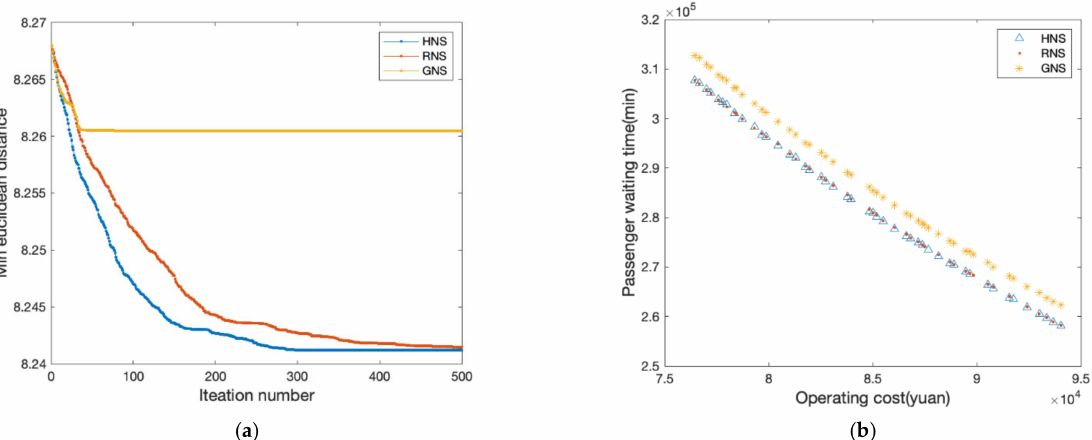
Figure 18. The comparison of different algorithms. ( a ) The iterative optimization effects of different algorithms; ( b ) the distribution of the final solution set of different